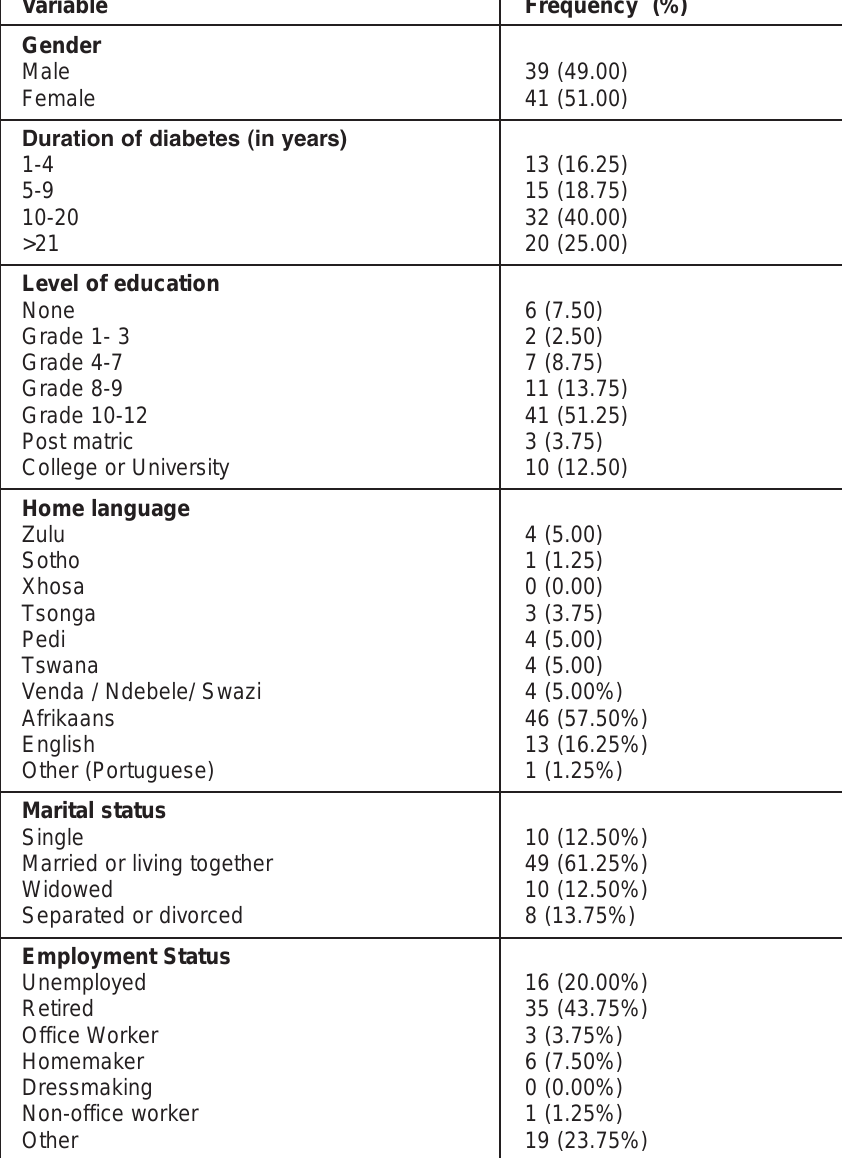
Table 1: Summary of demographic data (n=80)